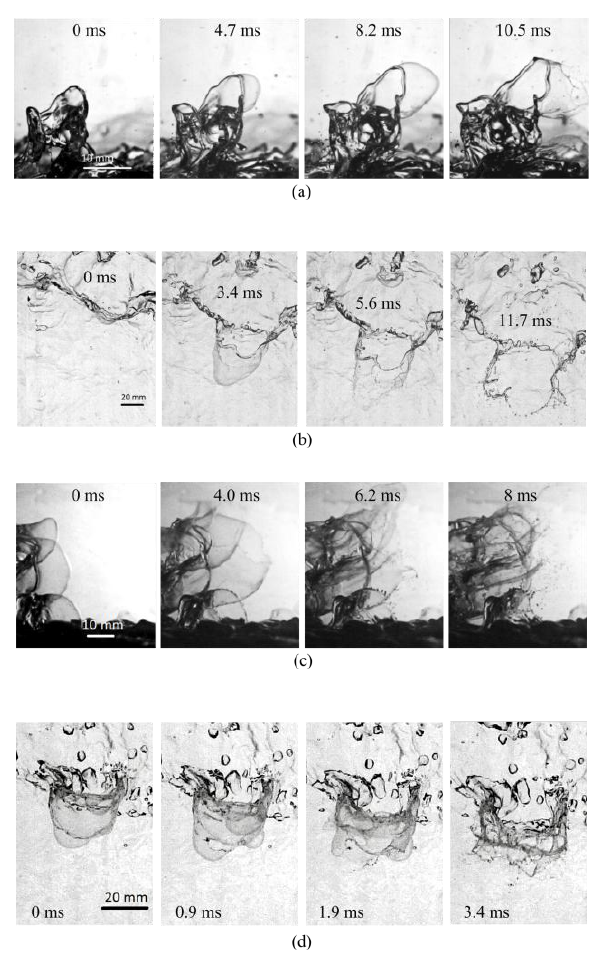
Fig. 4. The formation and rupture of a bag. A single bag: (a) side view, (b) top view. A “multi-bag”: (c) side view, (d) top view. U 10 =25